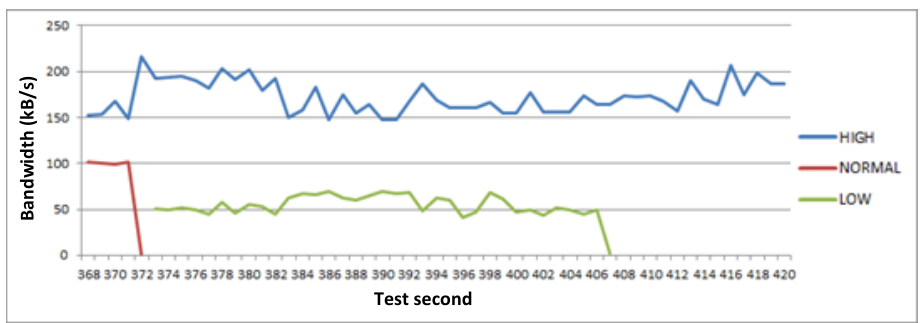
Figure 8. High priority request